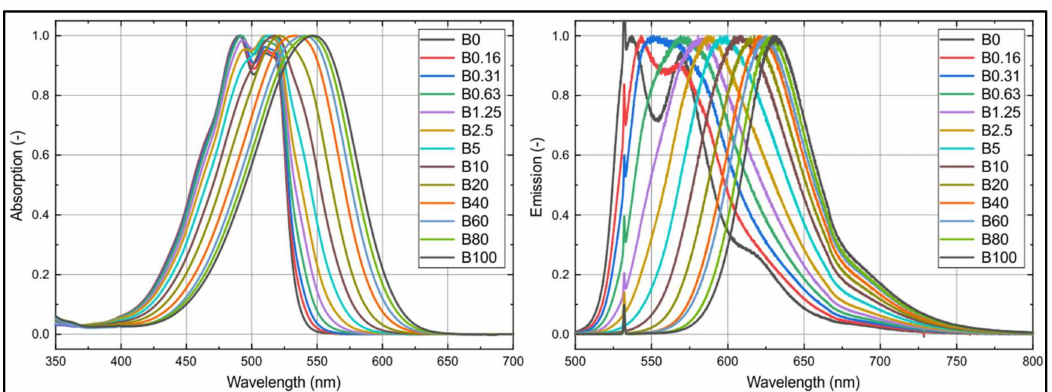
Figure 7. Absorption ( left ) and emission spectra ( right ) of nile red (7.5 mg / L) in n-decane at various butanol concentrations normalized to the respective maximum values; 293 K, 0.1